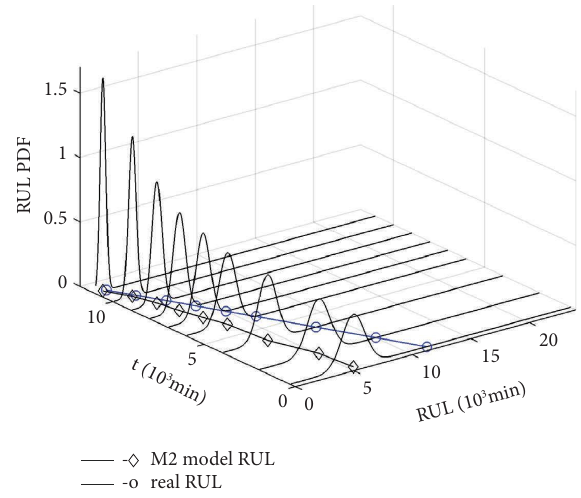
Figure 8: RUL estimation of the M3 model in a1 sample.